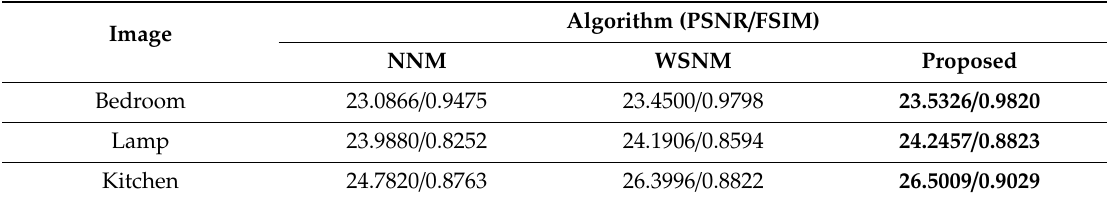
Table 3. PSNR / FSIM in experiment